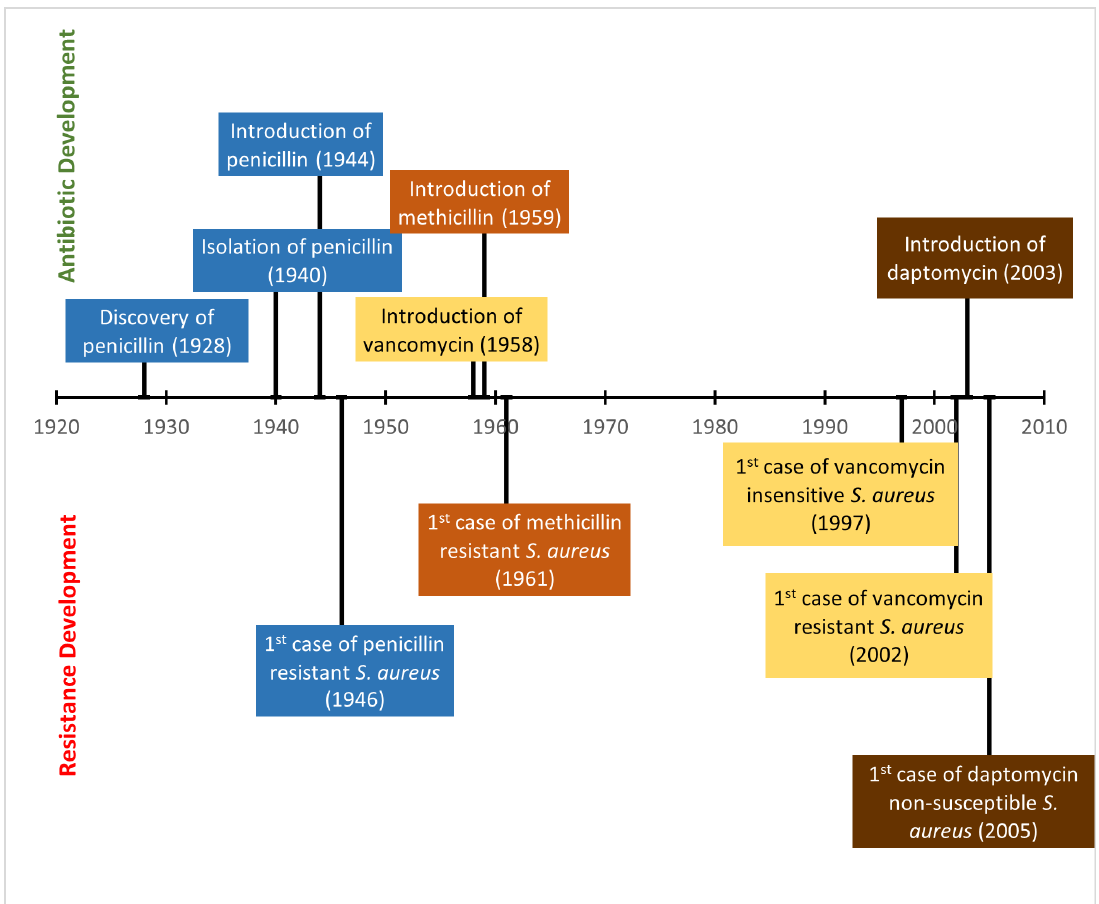
Figure 6. Timeline of development of antibiotic resistance in S. aureus .